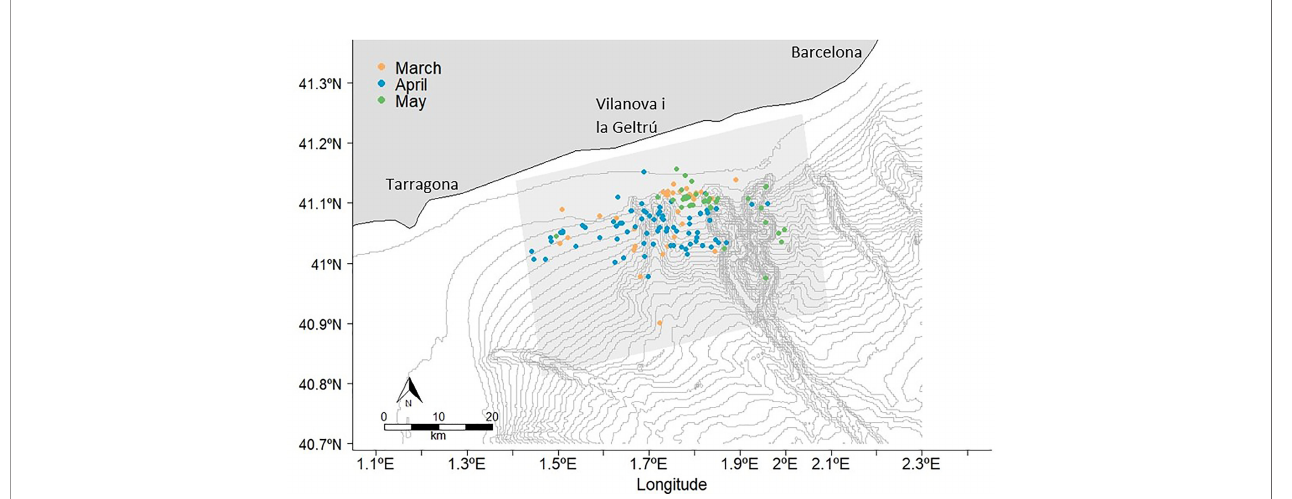
FIGURE 2 | Fin whale sightings between March-May 2021. The bathymetry lines have an interval of 50